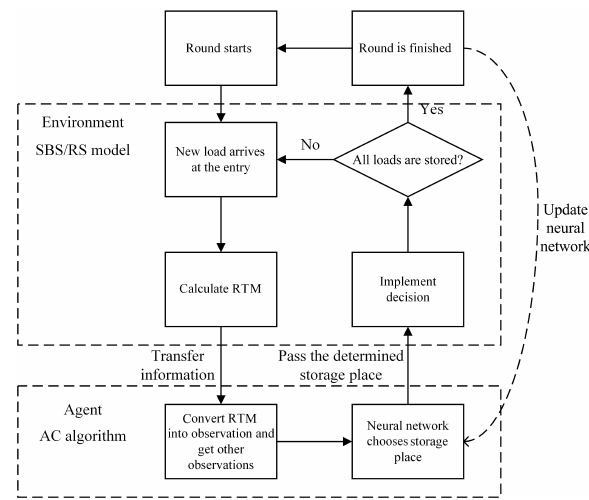
Fig. 7 Calculation of RTM. Fig. 8 Reinforcement learning in action on